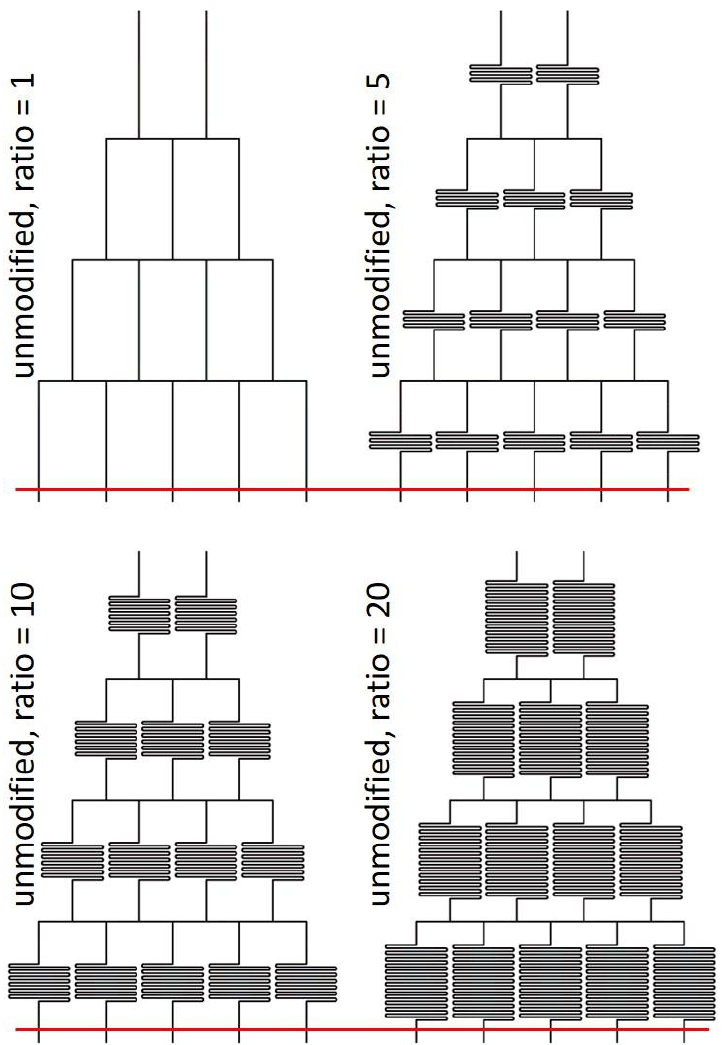
Figure 4. Designs of unmodified microfluidic chips with four different ratios of R V / R H .